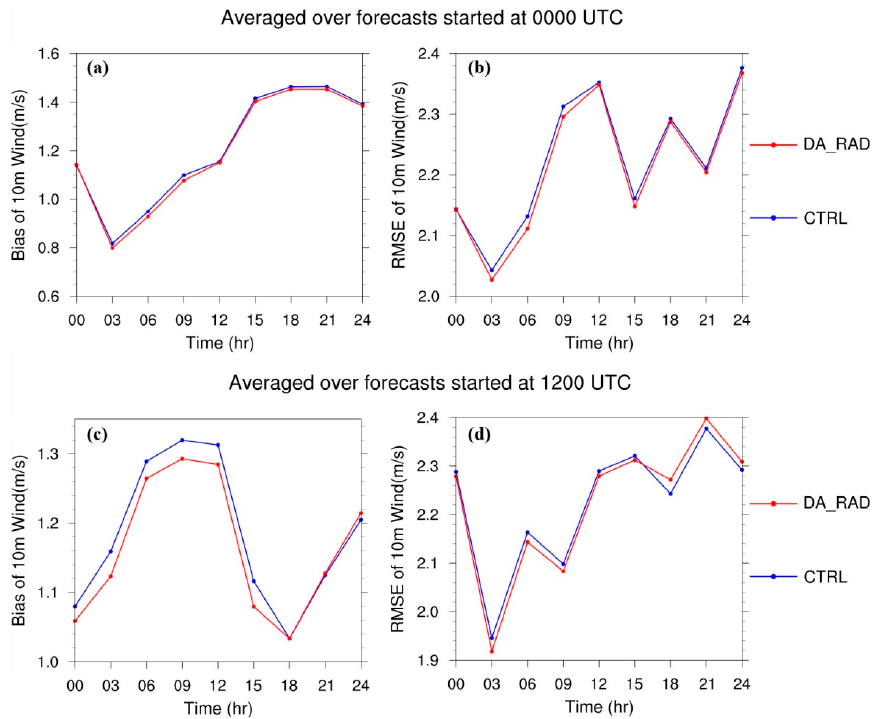
Figure 11. The averaged bias and RMSE of the temperature (TMP) vertical profiles at the analysis time